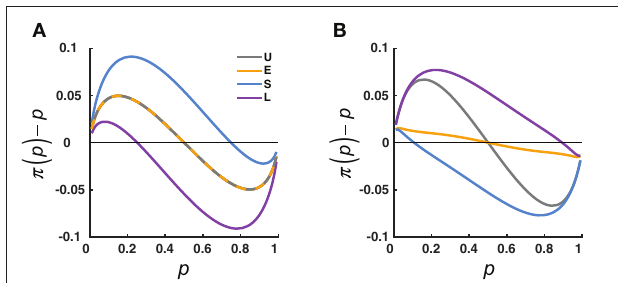
FIGURE 2 | Opposing effects predicted by two influential lines of theories . The predicted deviation of the subjective from objective relative-frequency, p , is plotted as a function of the objective relative-frequency, p , and π ( p ) − compared across the four distribution conditions (U, E, S, L, color coded). (A) Adaptation-level theory (Helson, 1947). The π ( p ) is assumed to reflect the difference between the p and a reference point known as “adaptation-level”, which shifts with the average value of the distribution. Thus, π ( p ) is repelled away from the concentrated areas of p : compared to the U condition, there is an overall overestimation for the S condition, and an overall underestimation for the L condition; there is no difference between the U and E conditions (the interleaved dashed lines), since the two have the same adaptation-level. (B) Judgment as Bayesian inference (Jazayeri and Shadlen, 2010). The subjective relative-frequency, π ( p ) , is assumed to be a posterior estimate that integrates the percept with the prior distribution of the objective relative-frequency.